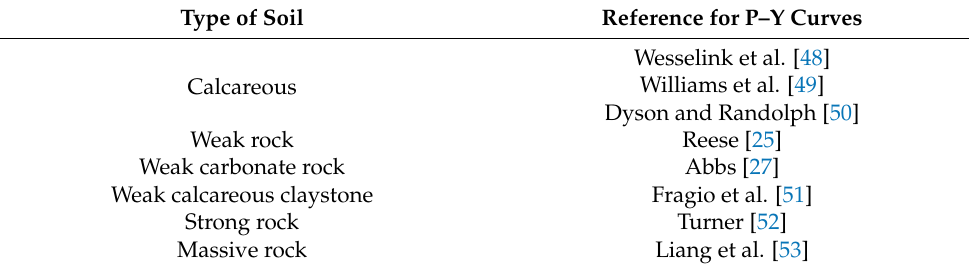
Table 1. Reference for P–Y curve construction for various rocky